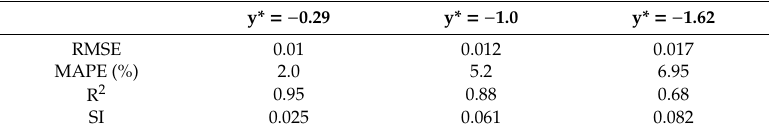
Table 1. Statistical index for the verification outcomes of the numerical model. y* = − 0.29 y* = −